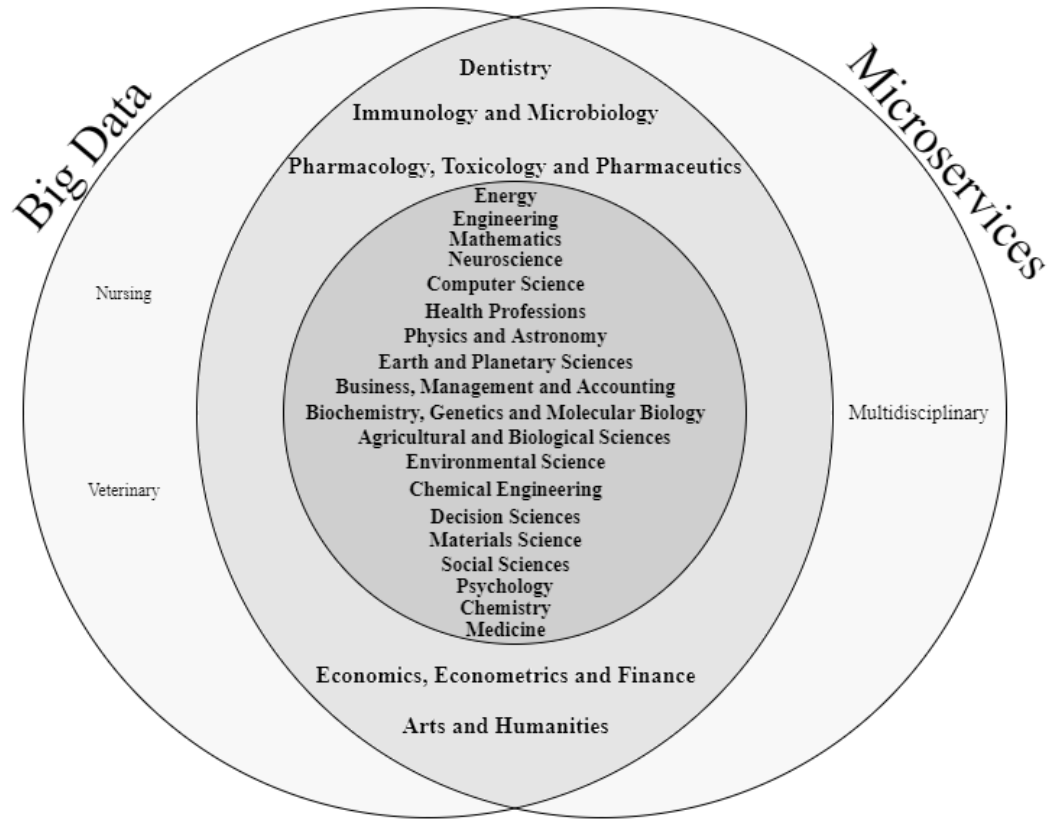
Figure 2. Depiction of the involved subject